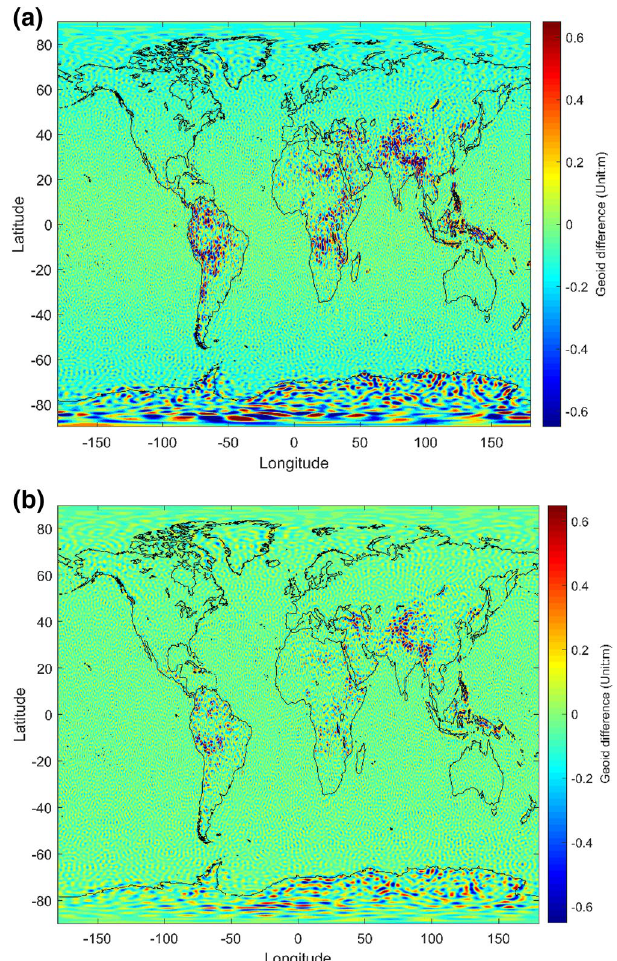
Figure 3. Cumulative geoid difference between I3GG and the existing gravity field models up to degree/order 210 (Unit: m): ( a ) EGM2008 ( b ) EIGEN-5C. These figures are generated by using Matlab(R2018a).